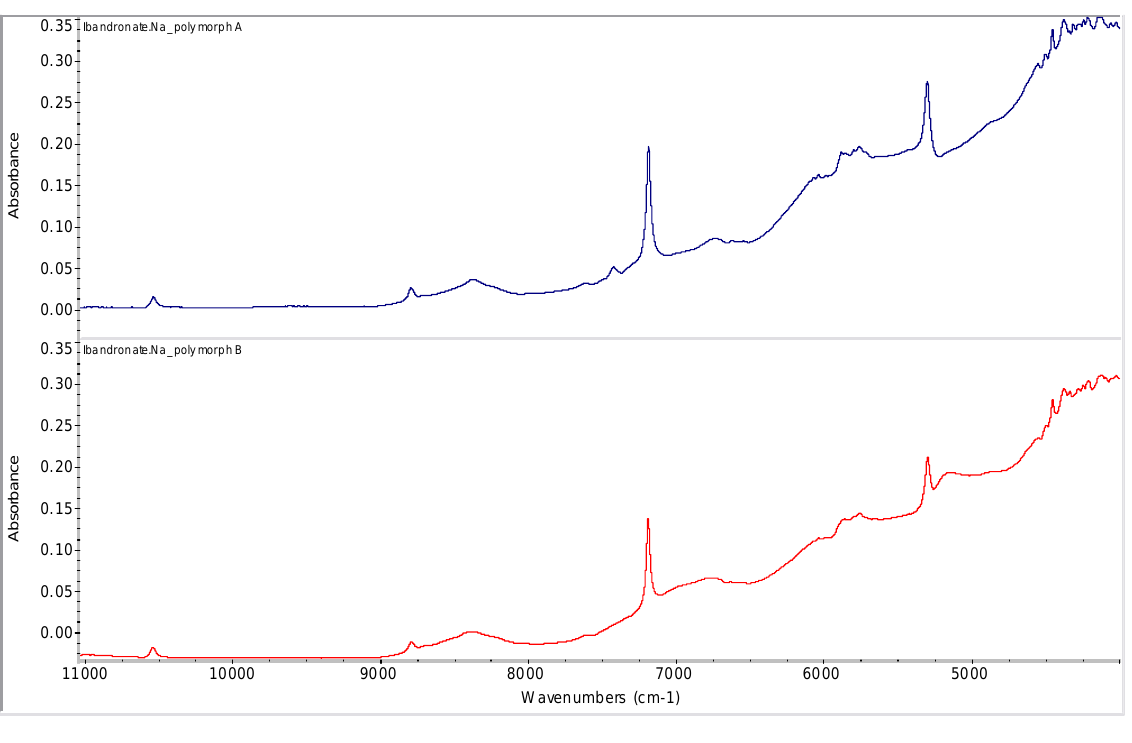
Figure 2. NIR spectra of ibandronate mono-sodium salt polymorph A and starting ibandronate monosodium salt polymorph